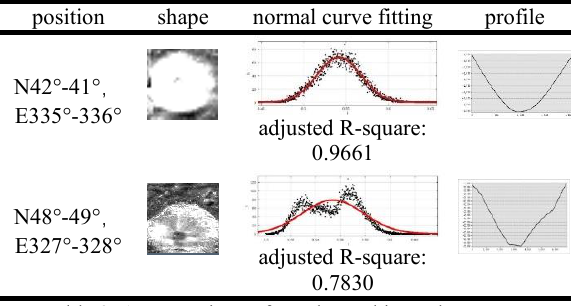
Table 2. A comparison of regular and irregular craters